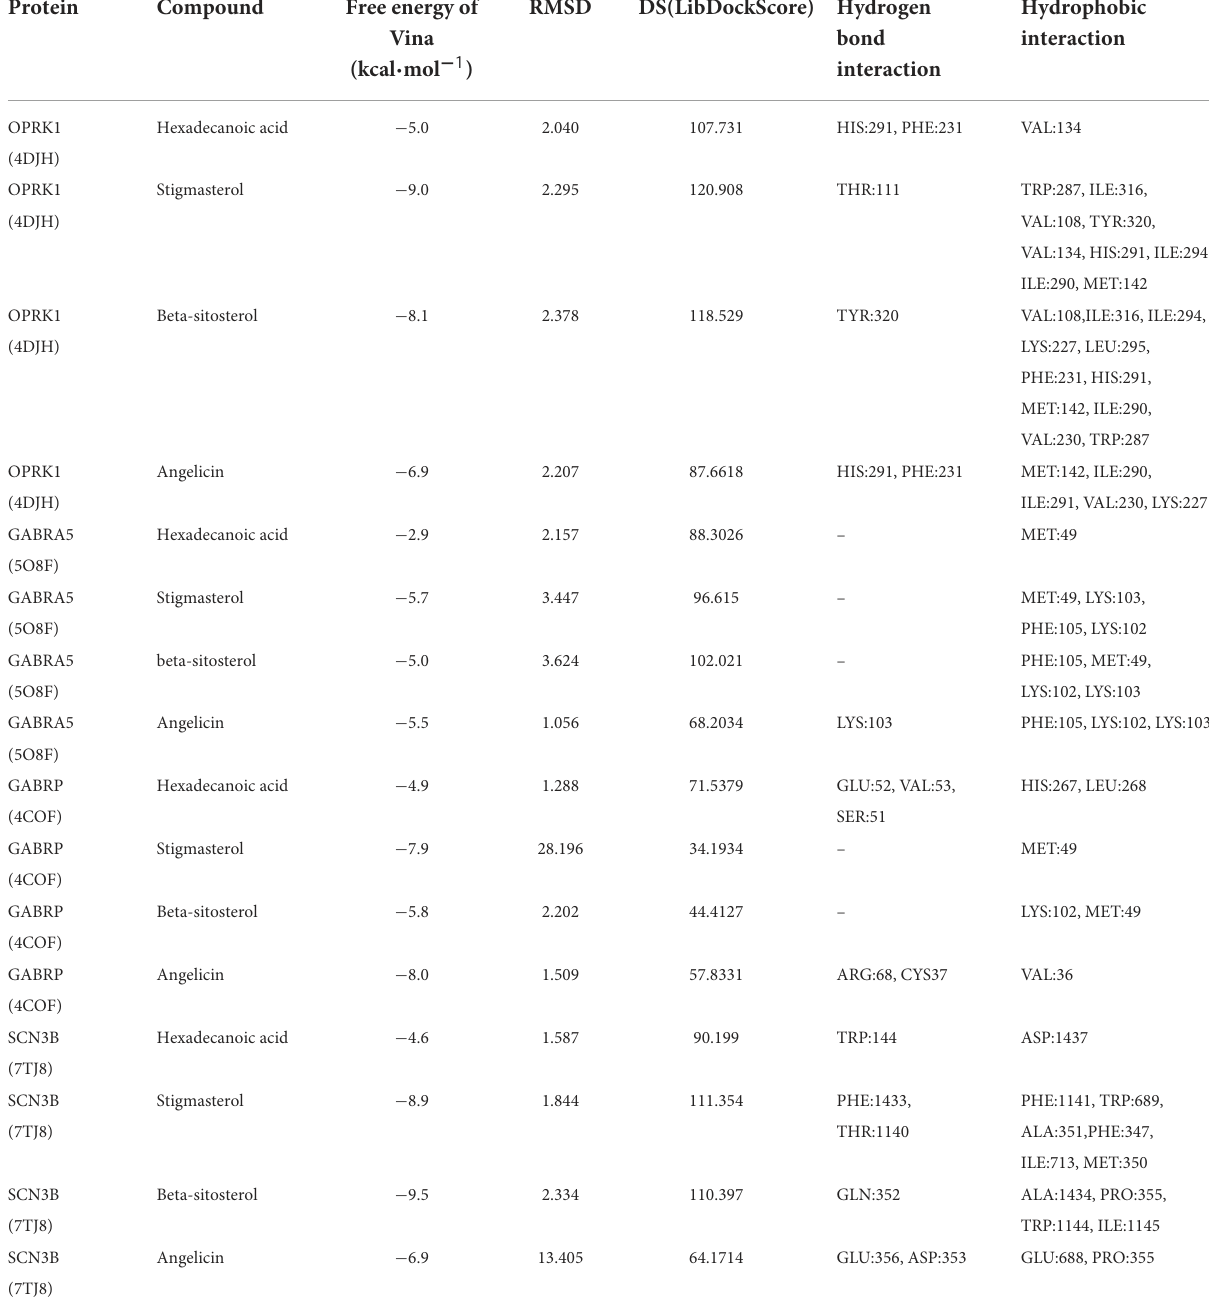
TABLE 1 Results of simulated molecular docking by Autodock-Vina, Discovery Studio 2019. Protein Compound Free energy of DS(LibDockScore) Hydrogen